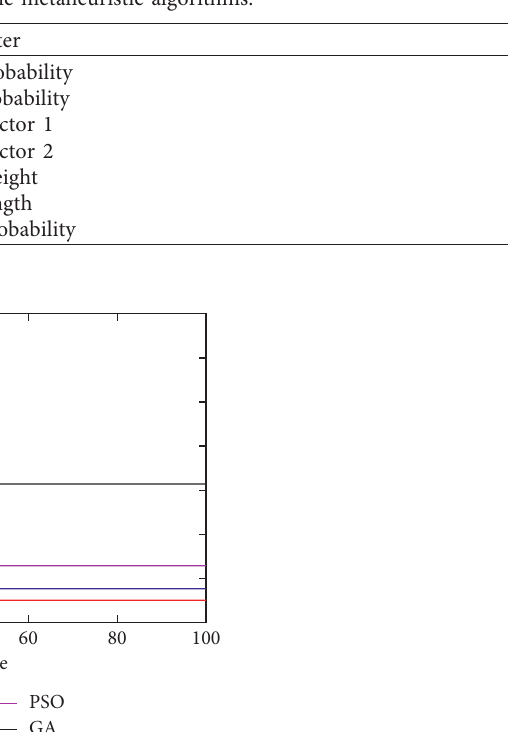
Table 5: Controlling parameters of the metaheuristic algorithms.